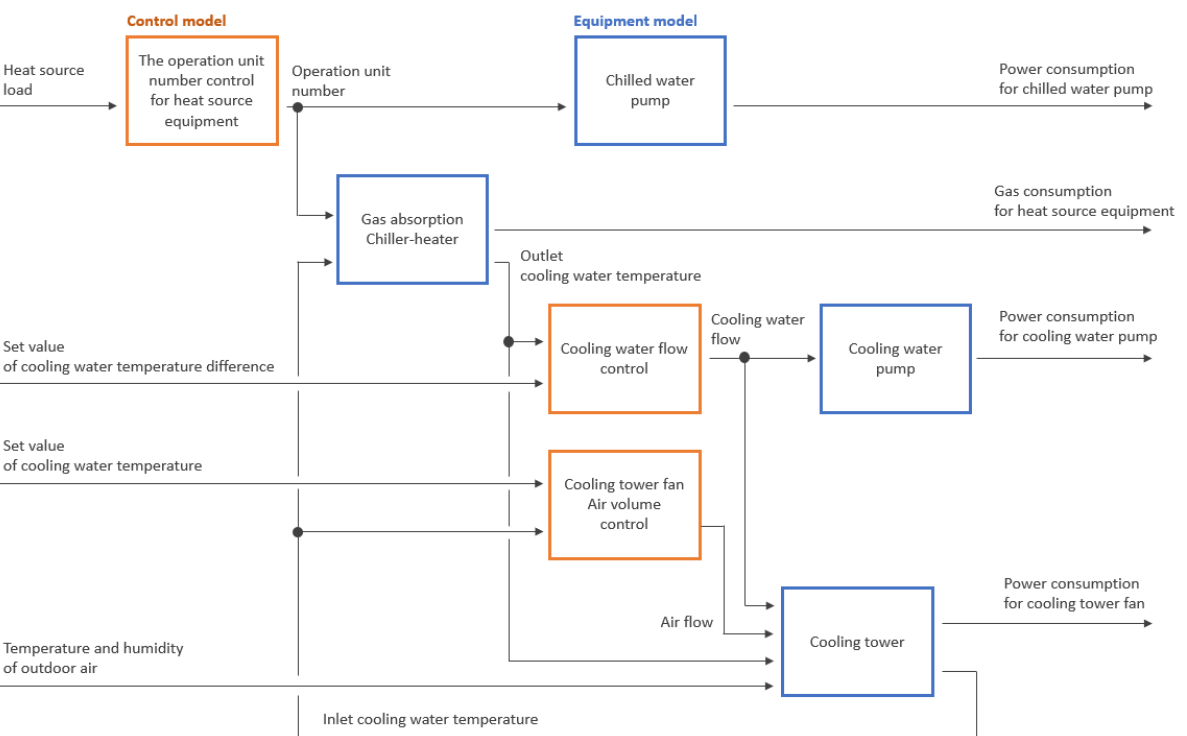
Figure 5. Simulation flow chart.